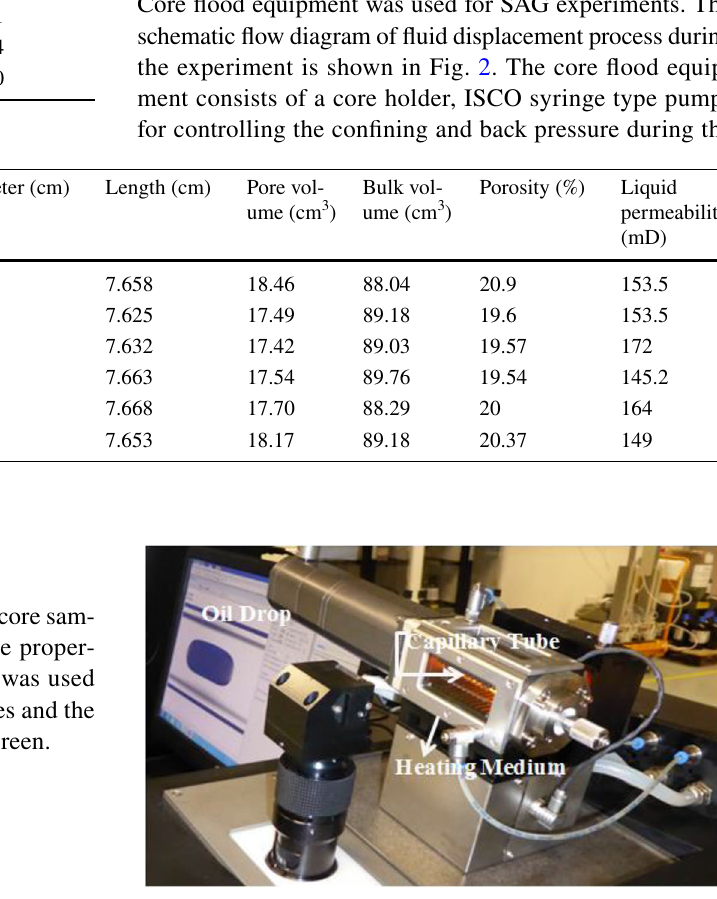
Fig. 1 Elliptical shape of oil drop during experiment by SV T20